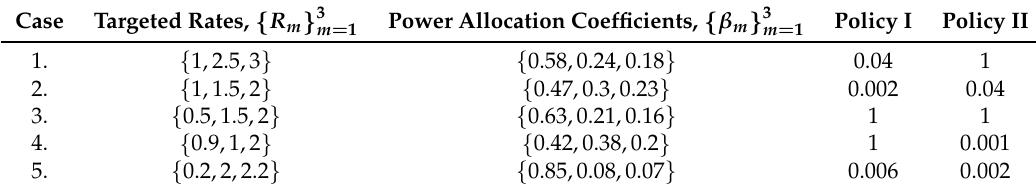
Table 3. Average outage comparison between two implementations of quality of service based